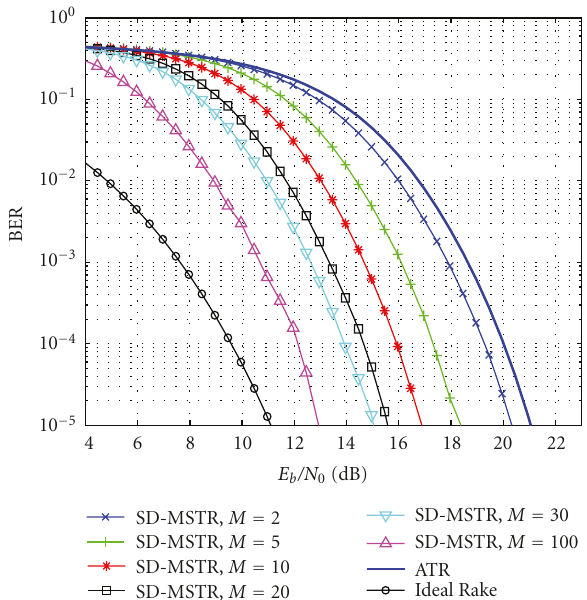
Figure 8: Average BER of SD-MSTR for di ff erent M over random channels, N = 10 .